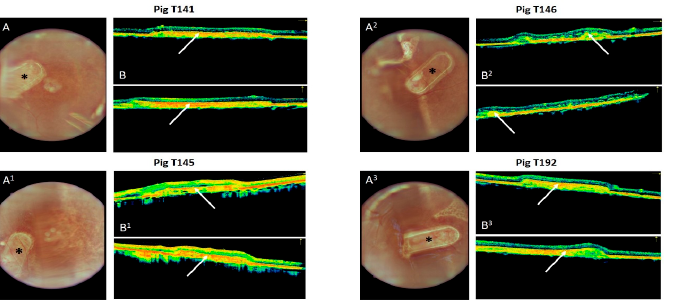
Figure 4. Fundus ( A ) and Optical Coherence Tomography ( B ) imaging of the implanted hRPEs on a nanofibrous carrier into minipigs. ( A , A 1 , A 2 , A 3 ) The star indicates the position of the implant in the superior nasal area of the retina. ( B , B 1 , B 2 , B 3 ) White arrow highlights the location of the implant underneath the retina in two cross-sectional images of the retina. The strong red line indicates the reflection from the RPE, which seems to be thicker in the area of the transplant.